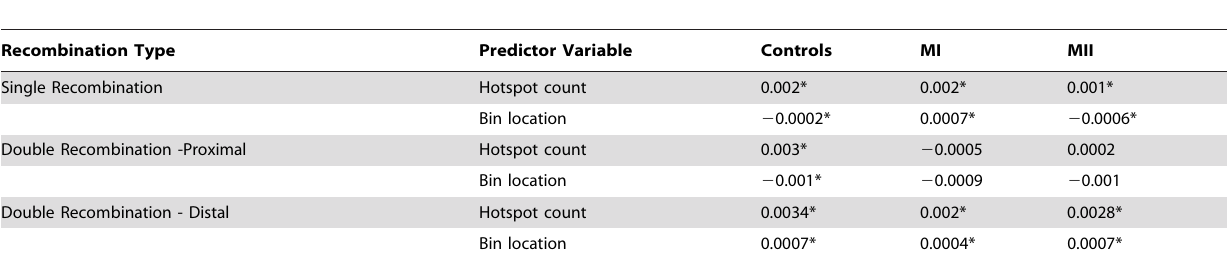
Table 5. Beta coefficient/slope values for hotspots variable adjusted by bin variable and stratified by meiotic outcome group and number of recombinants on chr21.